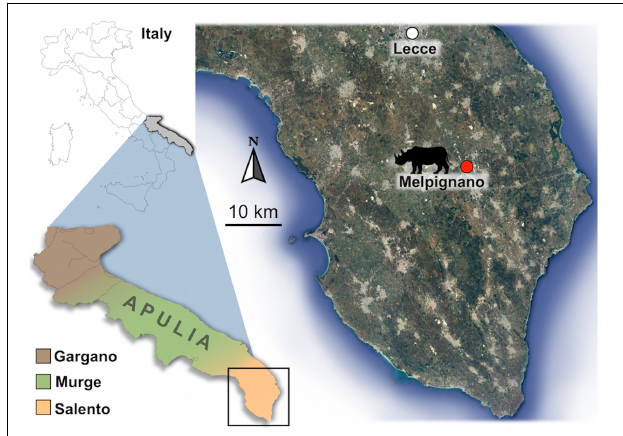
FIGURE 1 | Geographical location of the paleontological site of Melpignano (Lecce, Apulia, Italy).